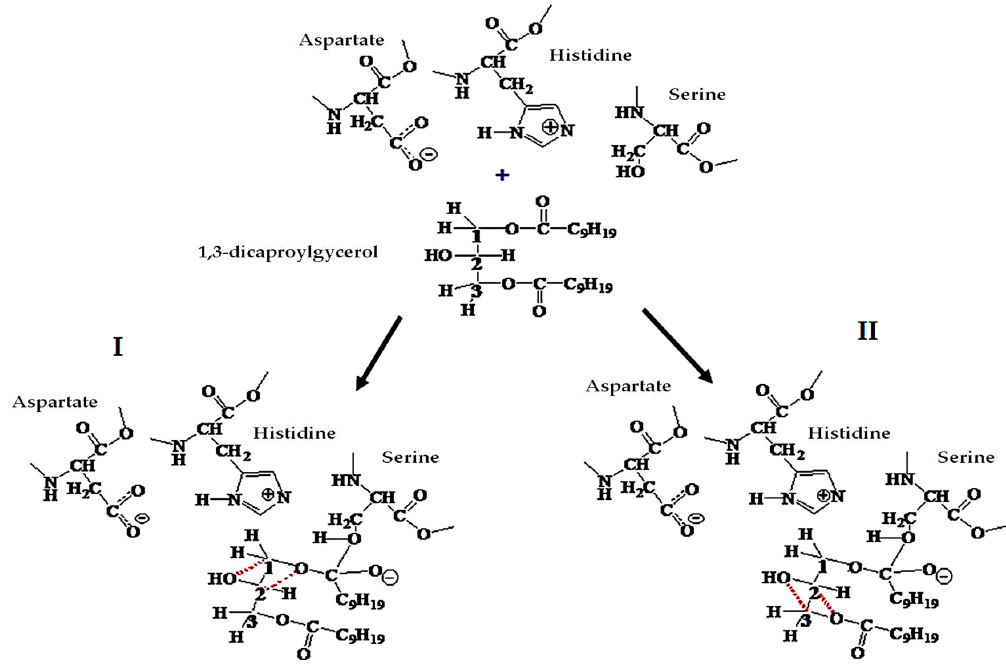
Figure 1. Scheme of 1,3-DAG with OH of C2 positioned near Histidine. ( I ) Acyl migration with the participation of the Serine and ( II ) Acyl migration mediated by the distribution of charges around the catalytic triad.